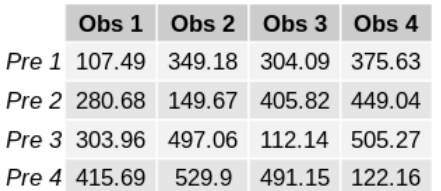
Figure 17. RMSE between the spatial patterns obtained for the future “Pre” (2020–2075) and the reference “Obs” (1971– 2000) modes of variability from the BCC-CSM1-1 simula- tions in autumn (September–October–November). Result for recipe_modes_of_variability.yml , see details in Sect. 3.2.5.